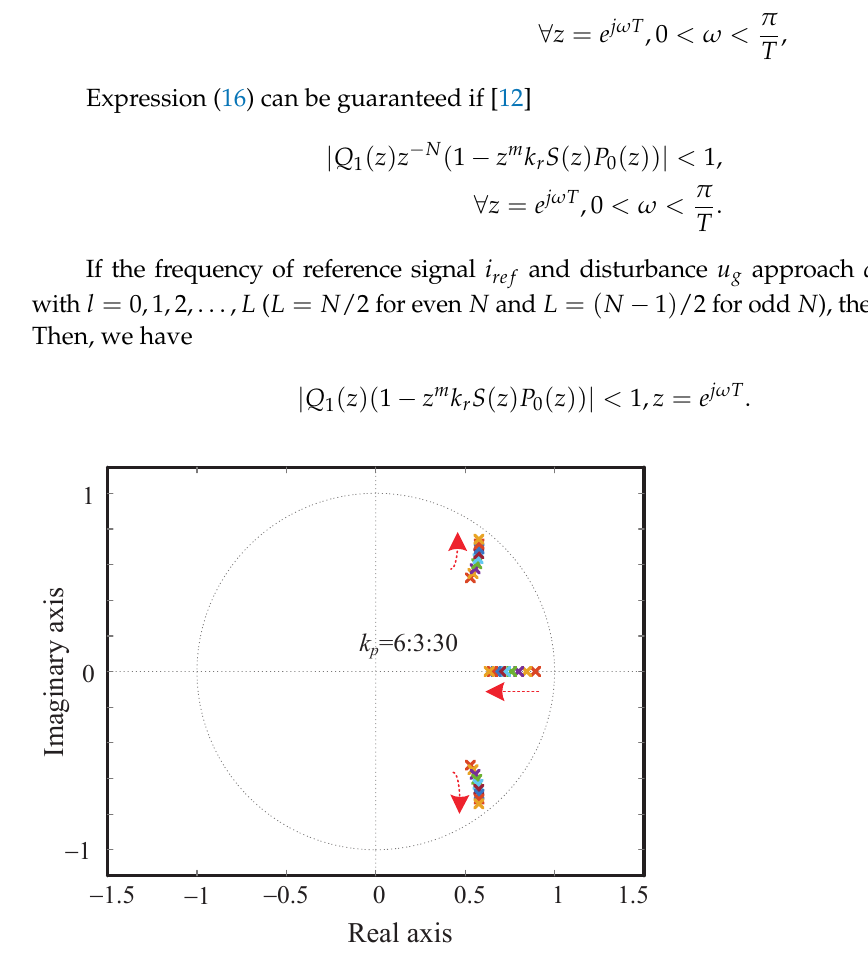
Figure 10. Distribution of the dominant poles of P 0 (z) with different k p . The Bode diagram of Q 1 ( z ) with Q ( z ) = 0.99 and Q ( z ) = 0.25 z + 0.5 + 0.25 z − 1 ,